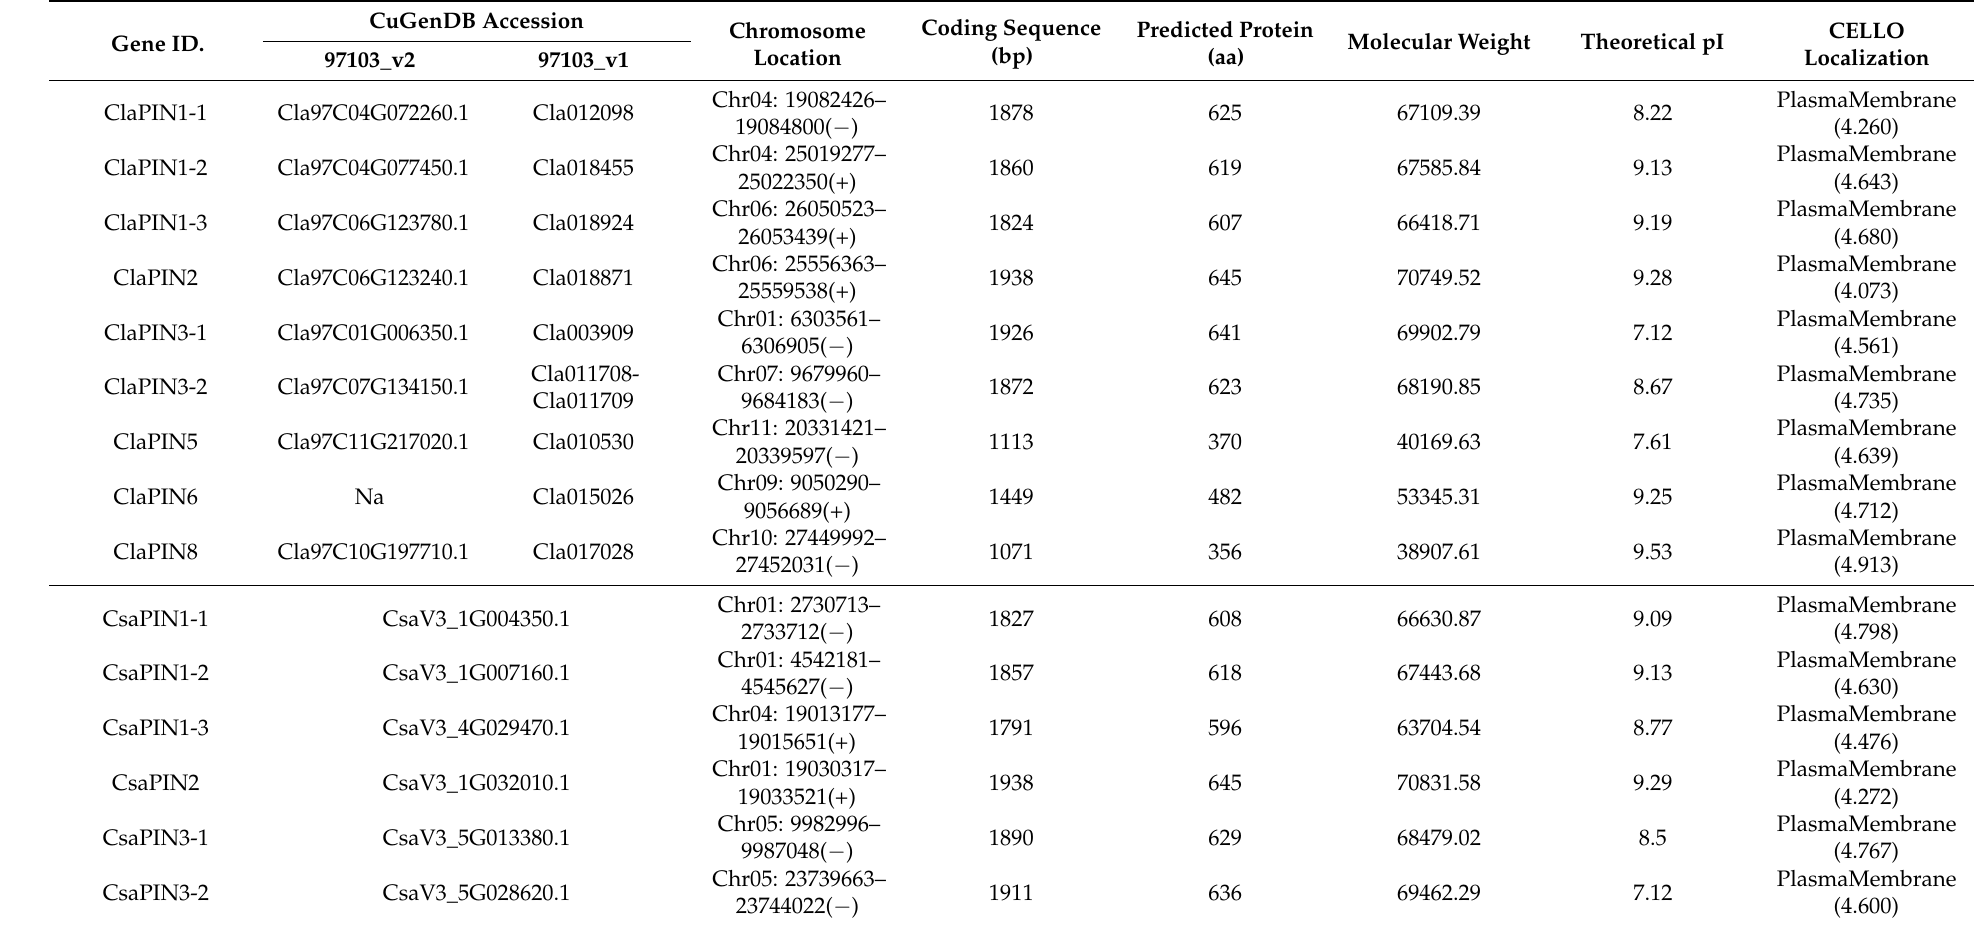
Table 1. The IDs, CuGenDB accessions, sequence lengths, molecular weights, pI, and CELLO localizations of PIN genes in watermelon, cucumber, and melon. Gene